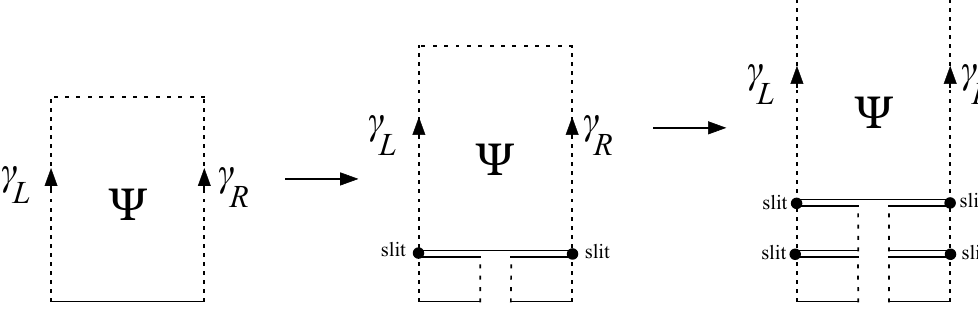
Figure 9 . The (cid:12)eld rede(cid:12)nition (2.38) e(cid:11)ectively attaches a (cid:13)ag and anti(cid:13)ag to the surface of the state of the target D-brane system. Repeated (cid:12)eld rede(cid:12)nition attaches more (cid:13)ags to the